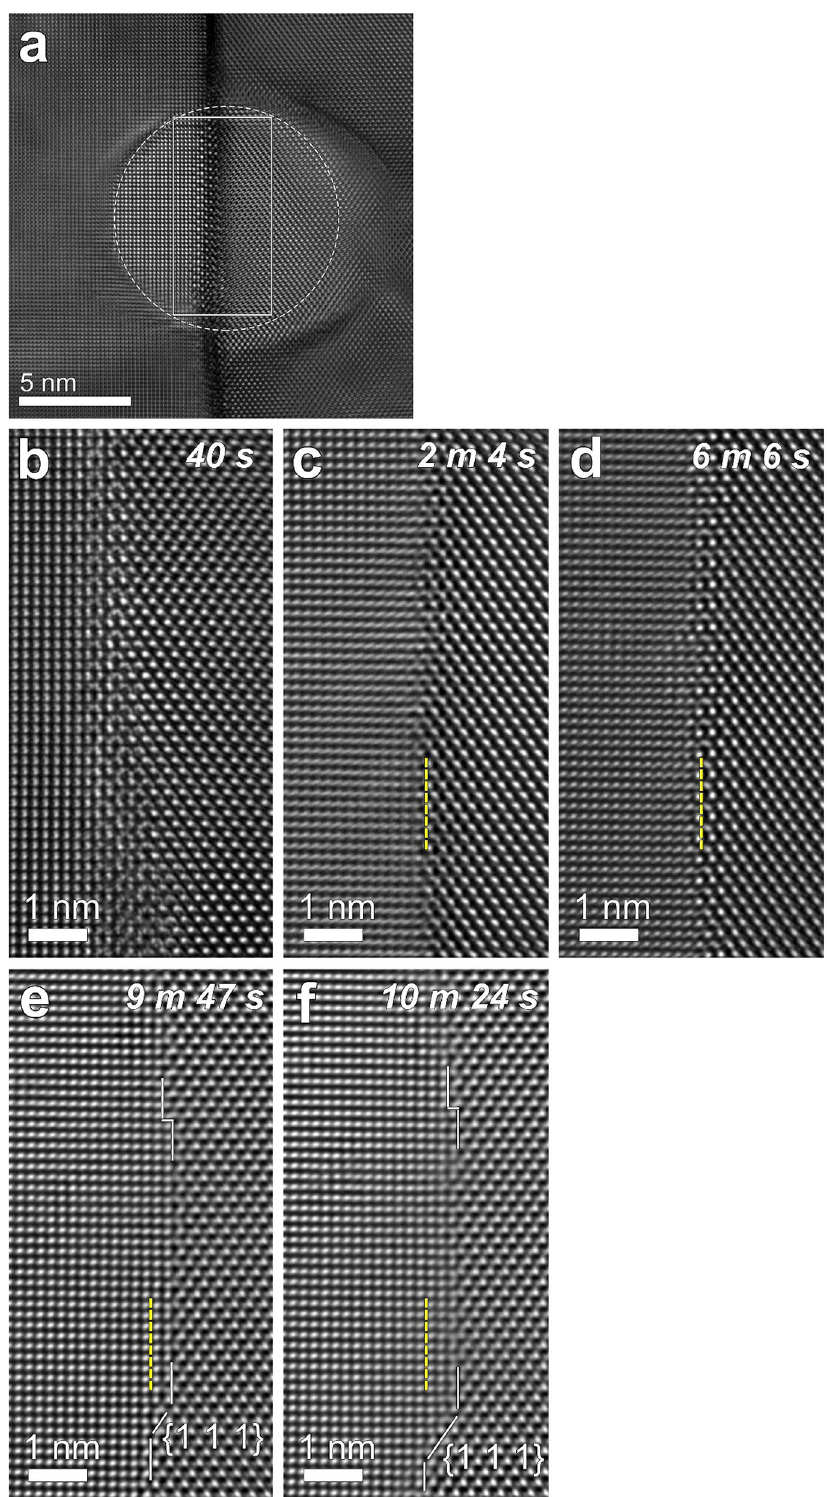
Figure 4 . ( a ) Sequential HRTEM images showing microstructural evolution of GB region after irradiation with a beam diameter of 10 nm (~ 5093 A cm –2 ) for 1 min 30 s. The irradiation diameter of 10 nm is marked by a dashed circle. The GB region in ( a ) was subsequently irradiated at 50 nm (~ 204 A cm –2 ). ( b – f ) Time evolution of the boxed region in ( a ) at 50 nm, which was imaged during in situ observation, as for Fig. 2. The elapsed time at 50 nm is specified in the upper right corner of each figure. The vertical dashed lines in the figures indicate the initial position of the GB shown in ( c